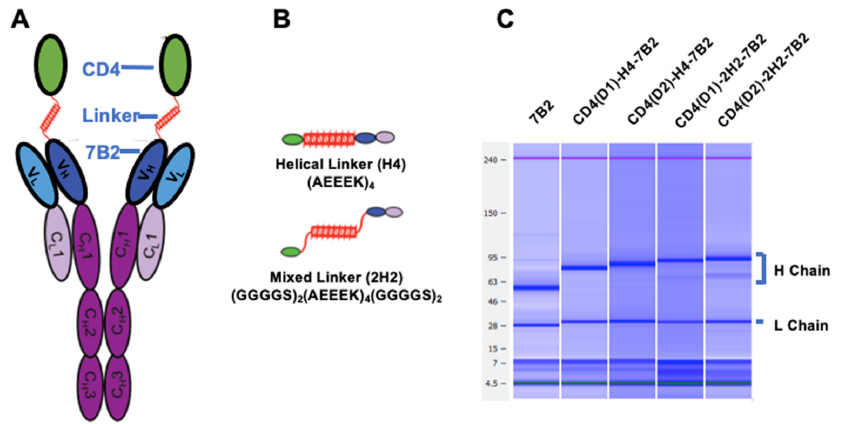
Figure 1. Construction of Ig-adhesins ( A ). Schematic diagram of CD4/7B2 chimeric adhesin,